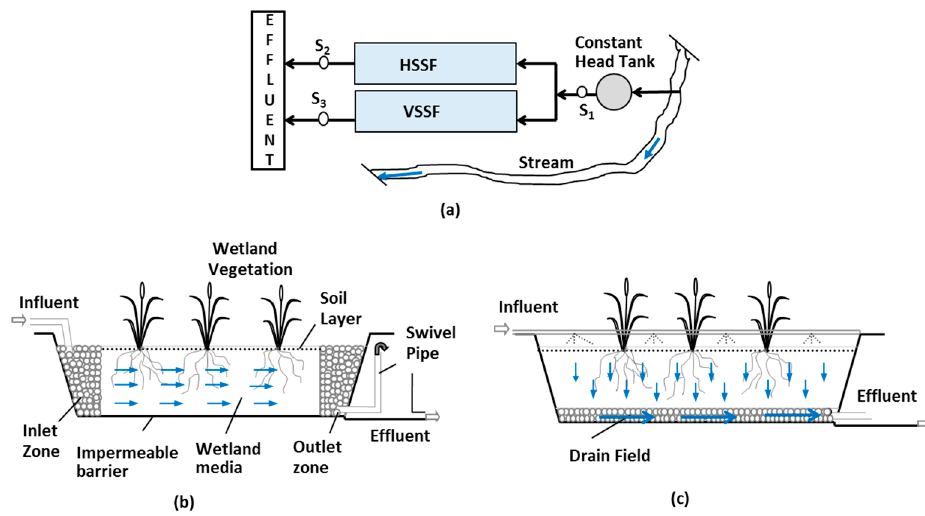
Figure 3. ( a ) Wetland arrangement: S 1 , S 2 and S 3 are sampling points. ( b ) Schematic diagram of a horizontal subsurface flow (HSSF) wetland system. ( c ) Schematic diagram of a vertical subsurface flow (VSSF) wetland system.